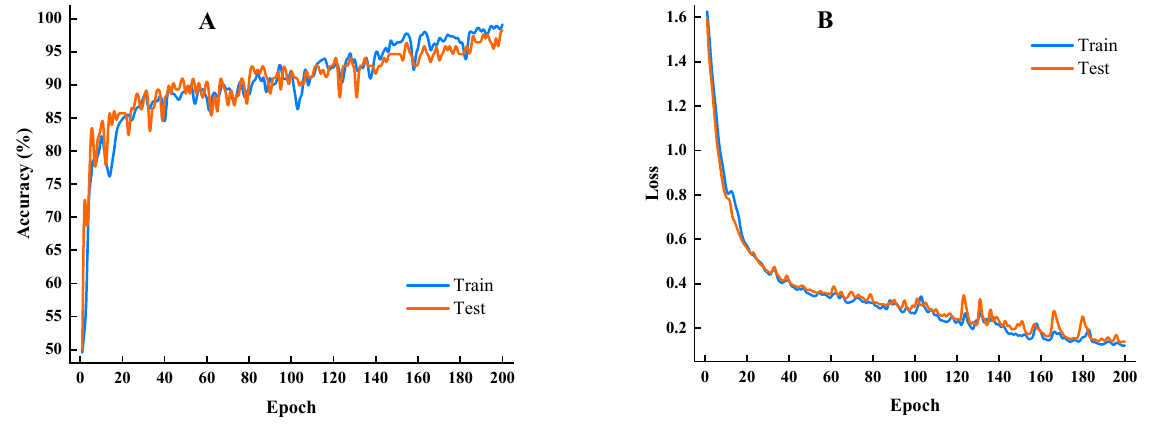
Figure 12. The training results of the CNN‑ATM network: ( A ) classification accuracy of the model;